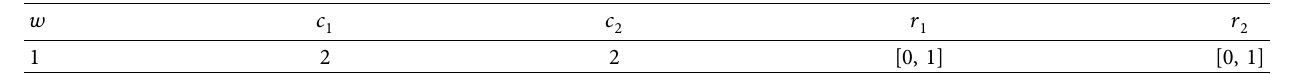
Figure 8: Flowchart of the optimal sailing speed by using PSO algorithm. Table 4: Parameters of PSO